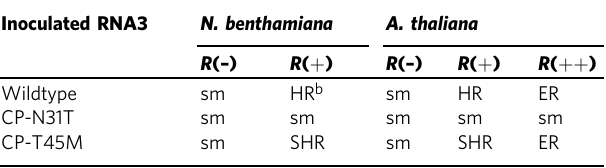
Table 1 Summary of observed phenotypes a after inoculations with different combinations of viral RNA3 genotypes and plant